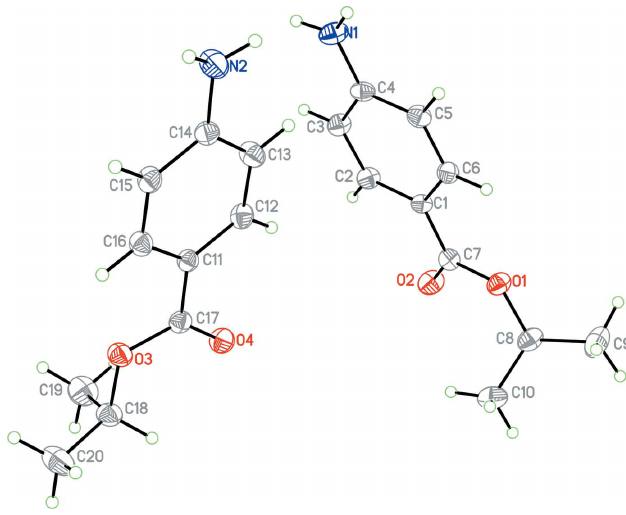
Figure 1 The molecular structure of I with displacement ellipsoids drawn at the 30% probability this angle is 67.8 (3) (cid:2) . For both molecules, the H atoms of the amino substituents are not coplanar with their attached phenyl ring. This is indicated by the dihedral angles between this group and its phenyl ring [11.5 (3) and 24.2 (5) (cid:2) for A and B , respectively] and the sum of the angles subtended at the N (358 and 352 (cid:2) for A and B , respectively), which shows that N2